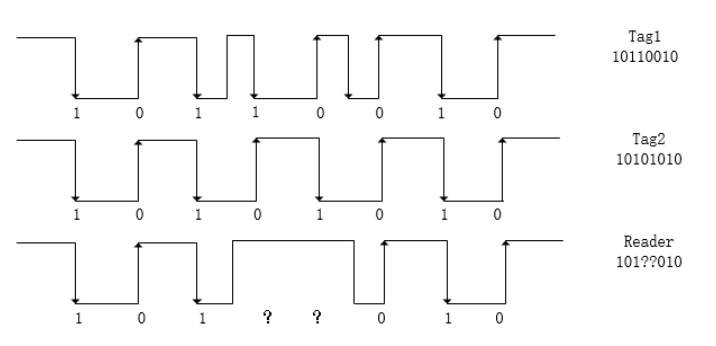
Figure 1. The sketch map of tracing the collision bits with Manchester